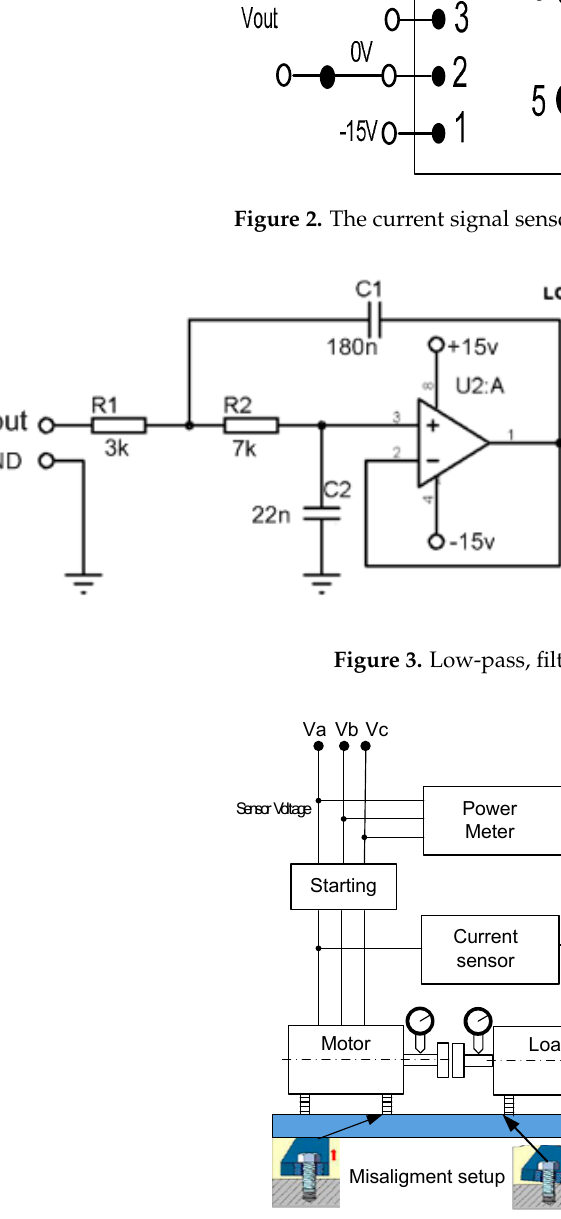
Figure 4. Testing diagram of the induction motor and equipment for data recording.